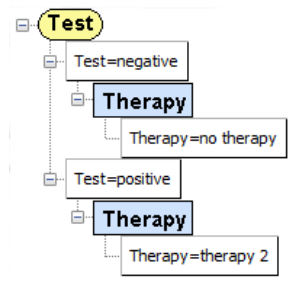
Figure 10. Optimal strategy for the ID of Figure 6. It is much more compact than the decision tree in Figure